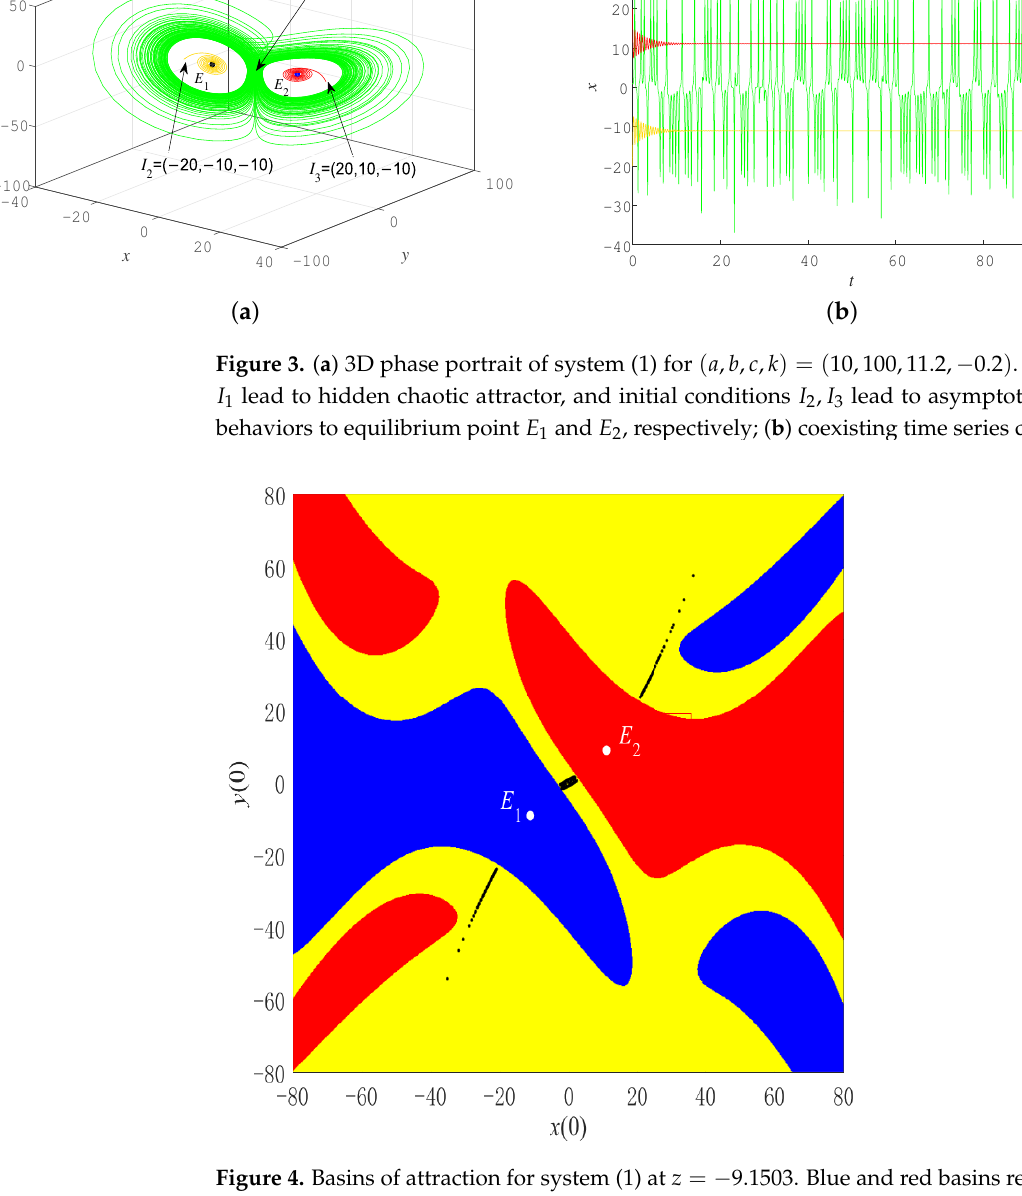
Figure 4. Basins of attraction for system (1) at z = − 9.1503. Blue and red basins represent attractors of two stable node-focus points E 1 and E 2 , yellow region denotes basin of chaotic attractor, and black stripes denote crossing trajectories of chaotic